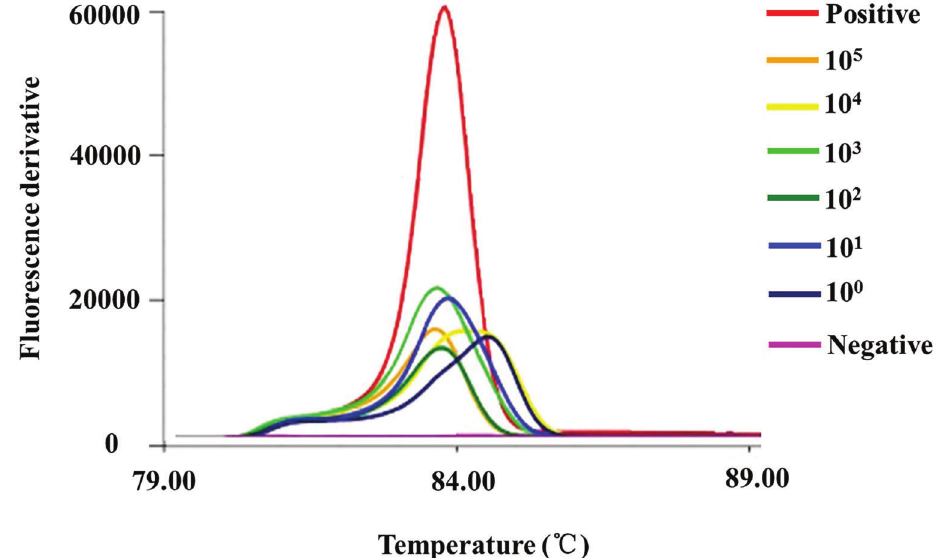
Figure 7. The melt curve of the products in loop-mediated isothermal ampli fi cation (LAMP) sensitivity reaction tubes for detecting the target gene of ureR_1 by Genie s II. The lysed suspension of K. pneumoniae and mouse blood were used as the template for LAMP test. The positive plasmid was the positive control and water was the negative control. The concentration of bacterium was from 10 5 – 10 0 . All experiments were repeated